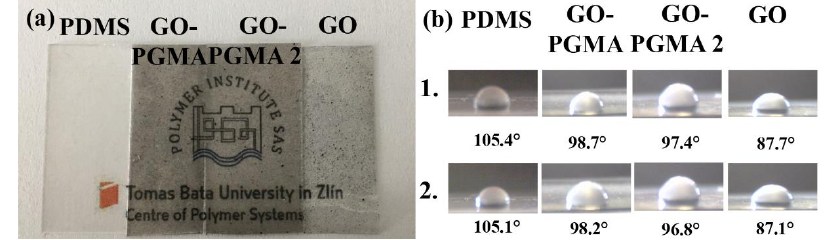
Figure 6. ( a ) Images of the neat PDMS and prepared composites and ( b ) Images from CCD camera of the 5 µ L water droplets on the neat PDMS and various composites. Line 1 represents measurements for as-prepared samples while line 2 represents the measurements of the samples after 7 days of storage at